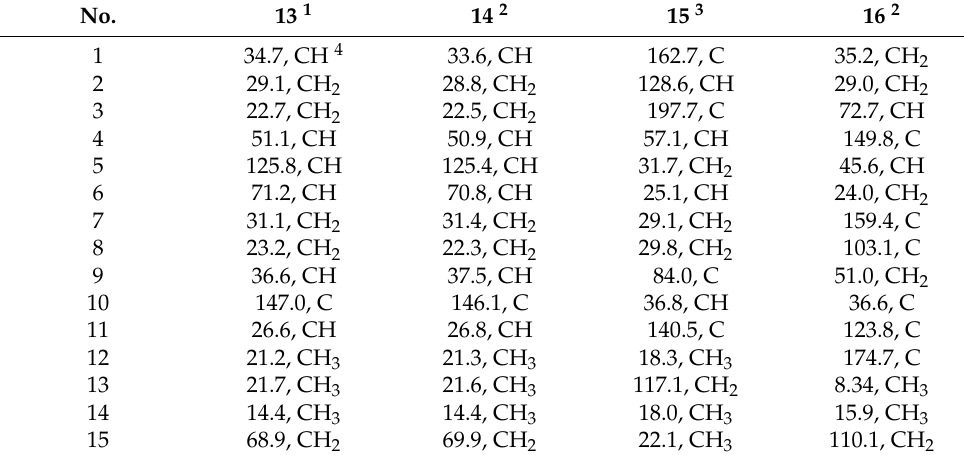
Table 6. 13 C NMR spectroscopic data of compounds 13 – 16 .